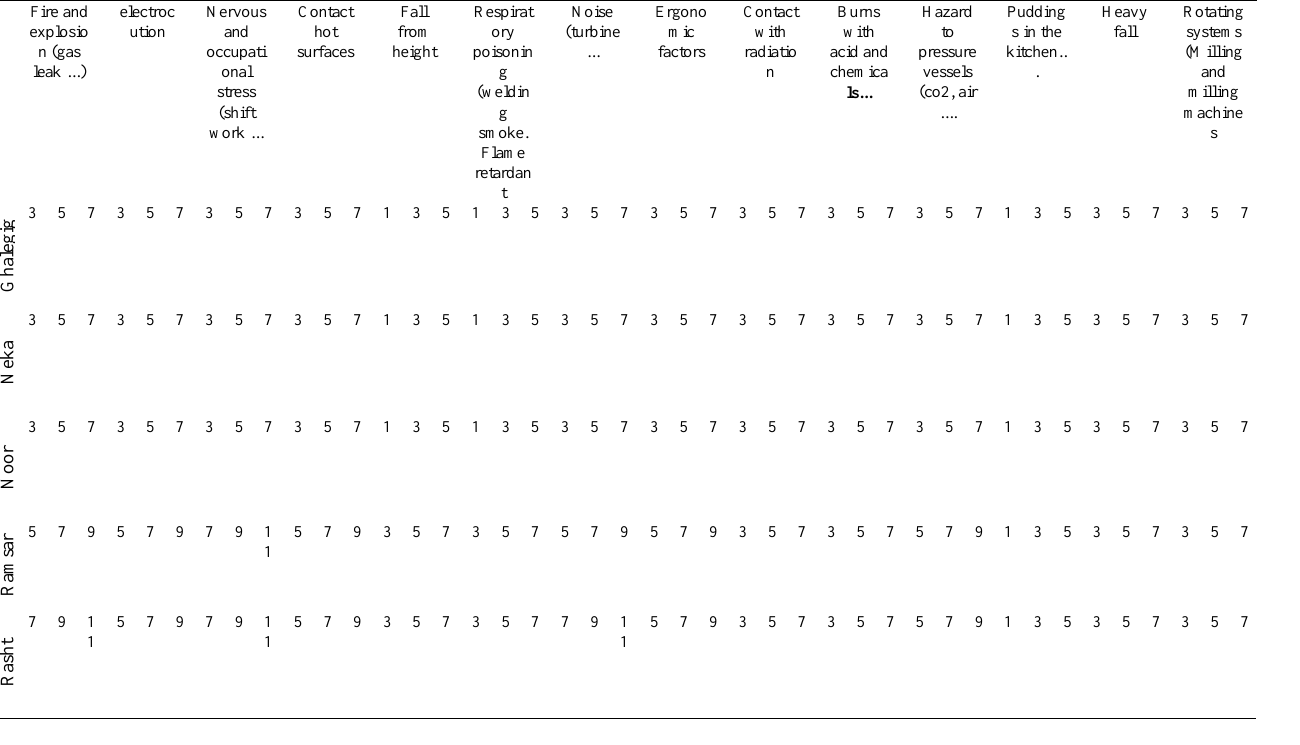
Rotating systems